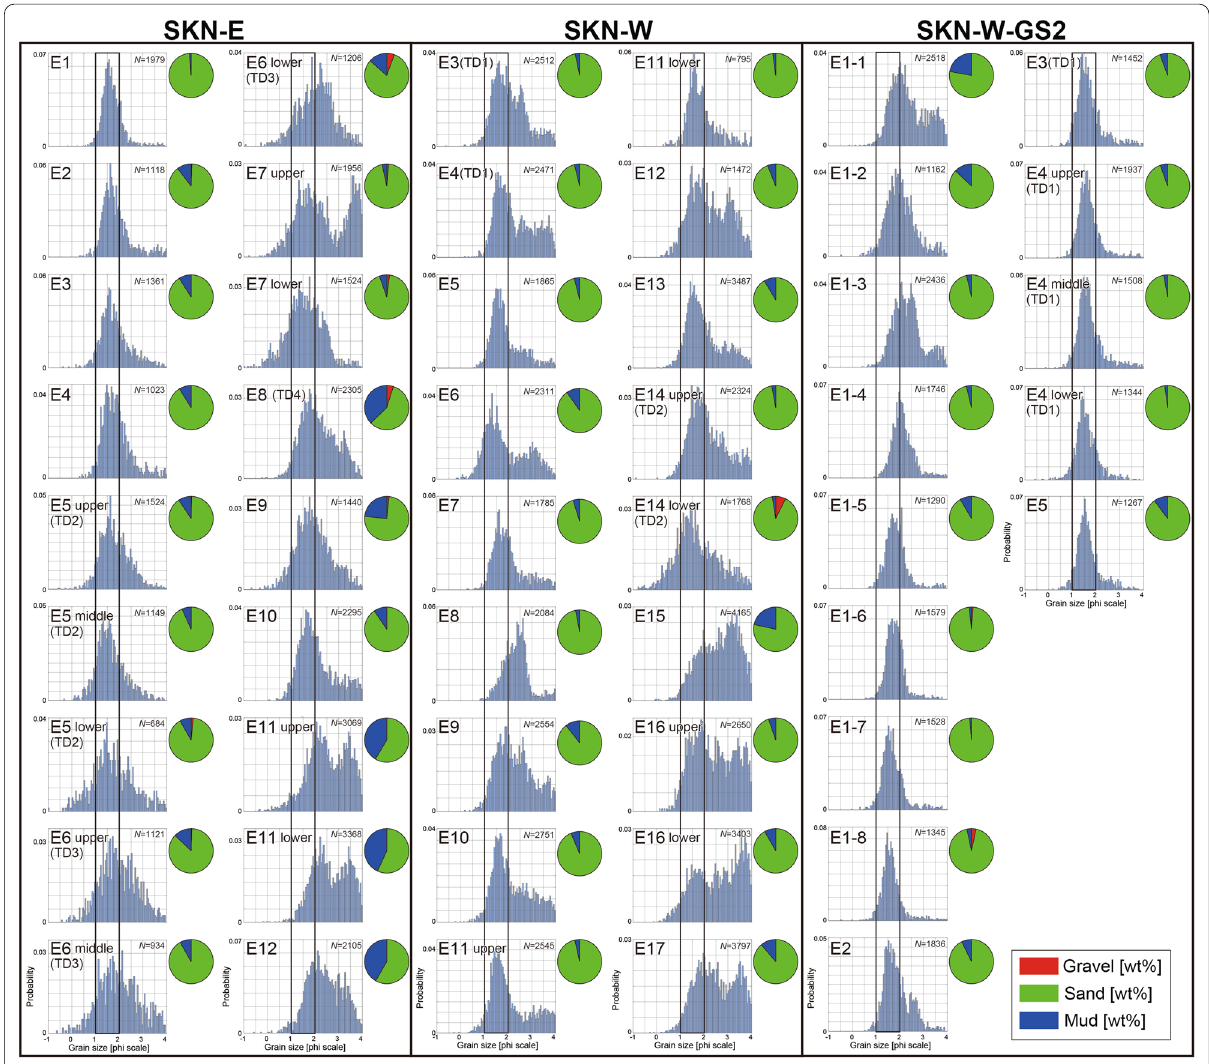
Fig. 3 Grain-size analysis of event deposits in SKN-E and SKN-W outcrops and GS-W-GS2 core. Histograms show phi-scale grain-size distributions. Vertical axis indicates the probability of particles. Pie charts show gravel, sand, and mud contents. N means the number of particle samples measured. Mean, median, mode, skewness, and kurtosis of each histogram are shown in Additional file 2: Table